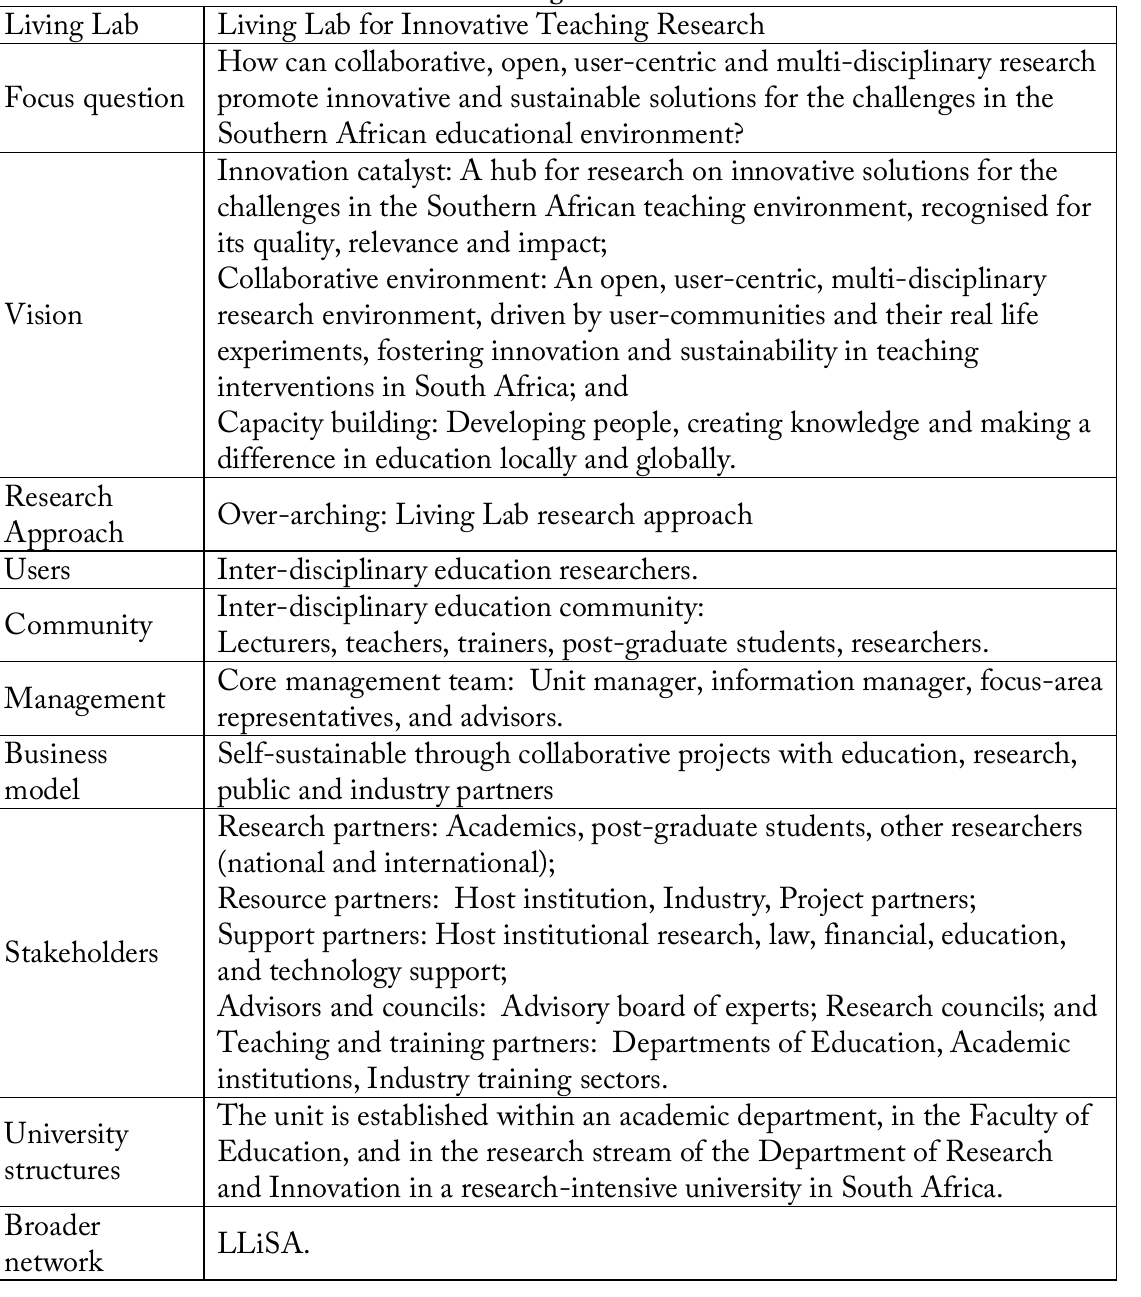
Table 1: Living Lab